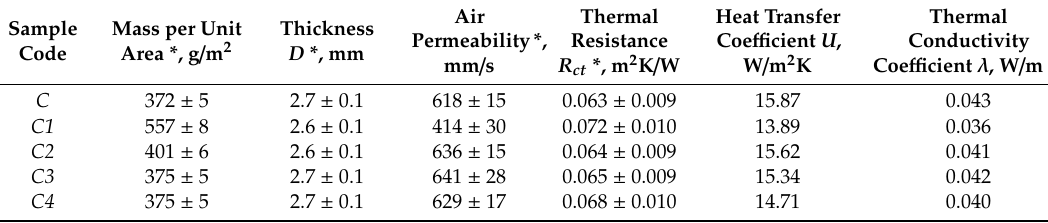
Table 5. Measurement results of investigated